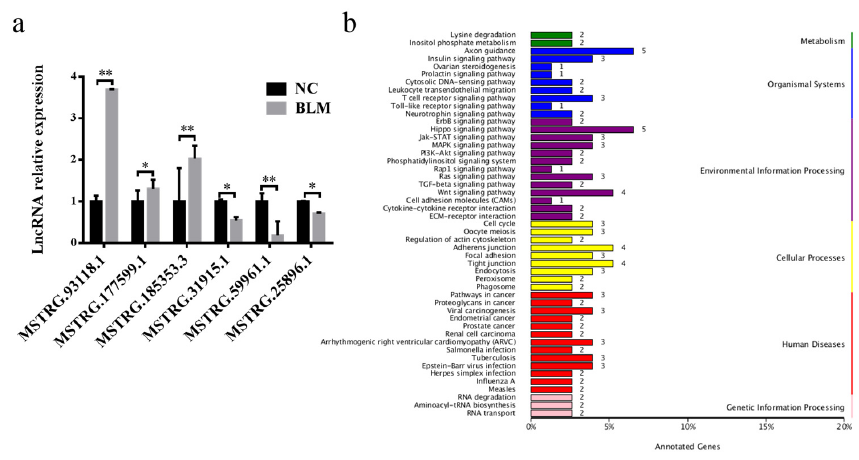
Figure 4. Identification of differentially expressed lncRNAs. ( a ) Expression of up- and downregulated lncRNAs in the NC and BLM groups, as determined by RT–PCR. ( b ) KEGG pathway analysis of differentially expressed lncRNAs. Significant differences are represented with * ( p < 0.05) and ** ( p < 0.01).